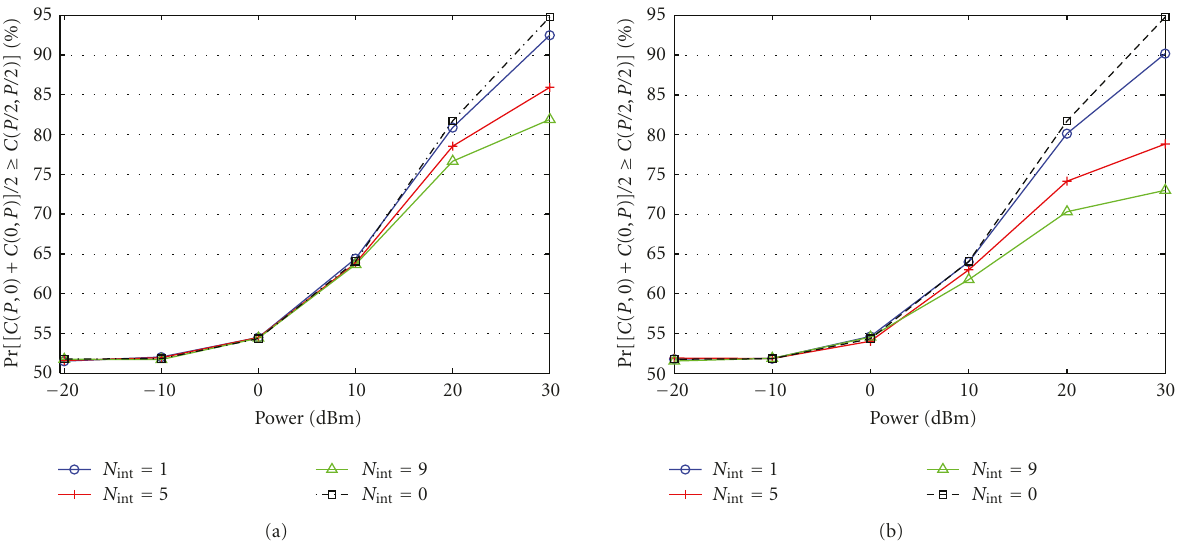
Figure 11: Percentage of points where sequential outperforms simultaneous transmission at di ff erent power levels and di ff erent number of background interferers N int . Of note is the significant e ff ect of background interference at high power levels P > 10 dBm. (a) Exclusion radius R ex = 500 m, (b) Exclusion radius R ex = 50